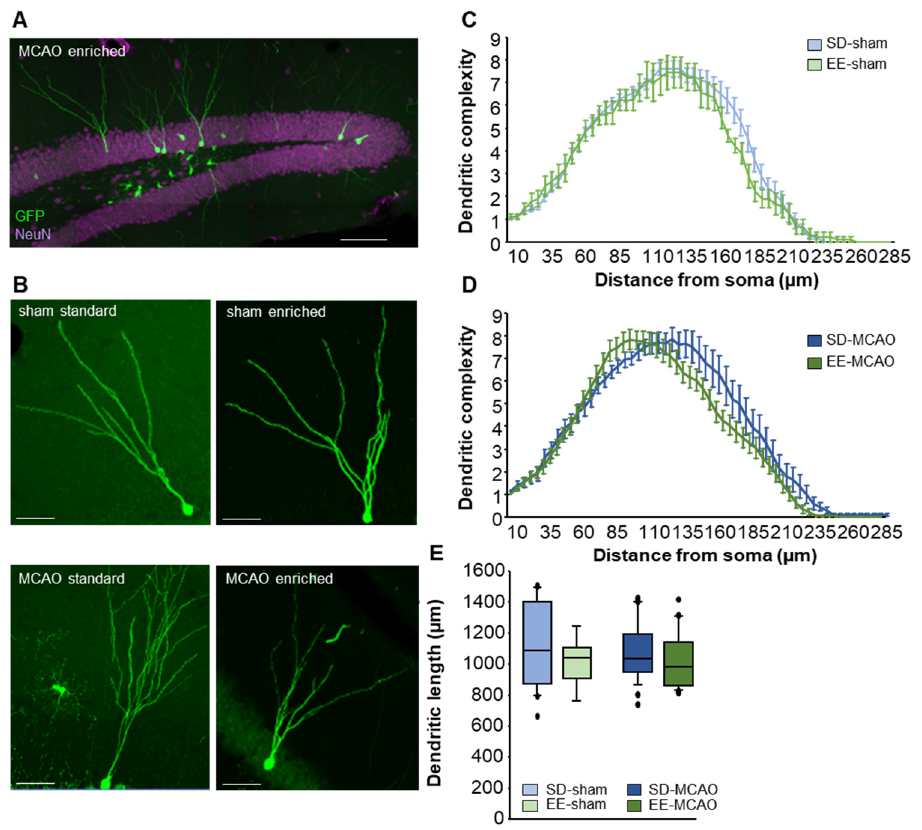
Figure 6. Morphological analysis of newly generated neurons in the dentate gyrus. ( A ) Overview images GFP-labelled neurons in the dentate gyrus of an EE-MCAO animal (GFP green, NeuN purple). Scale bar = 100 µm ( B ) Representative confocal images of 42 days GFP-positive neurons in the different groups post-surgery. Scale bar = 50 µm. ( C – E ) Dendritic length and complexity of newly generated GFP-positive neurons in the different groups. No significant differences were found between sham and MCAO groups. Statistical analysis was performed using linear mixed model for dendritic length and One-way ANOVA with post-hoc Bonferroni for dendritic complexity.